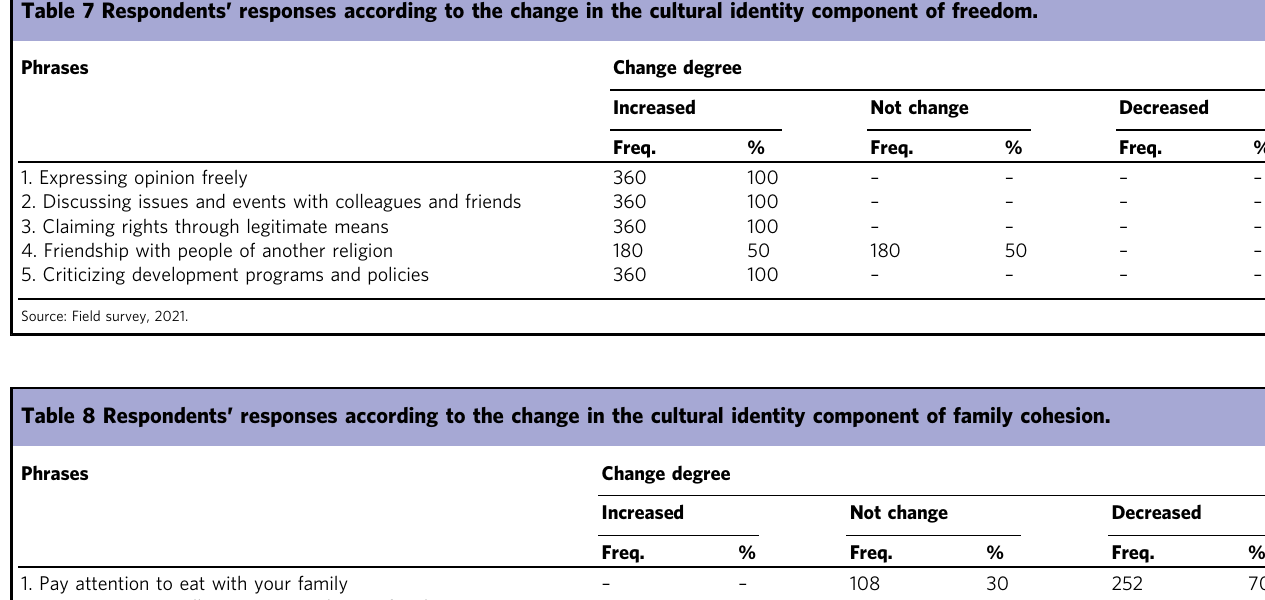
Table 7 Respondents ’ responses according to the change in the cultural identity component of freedom.